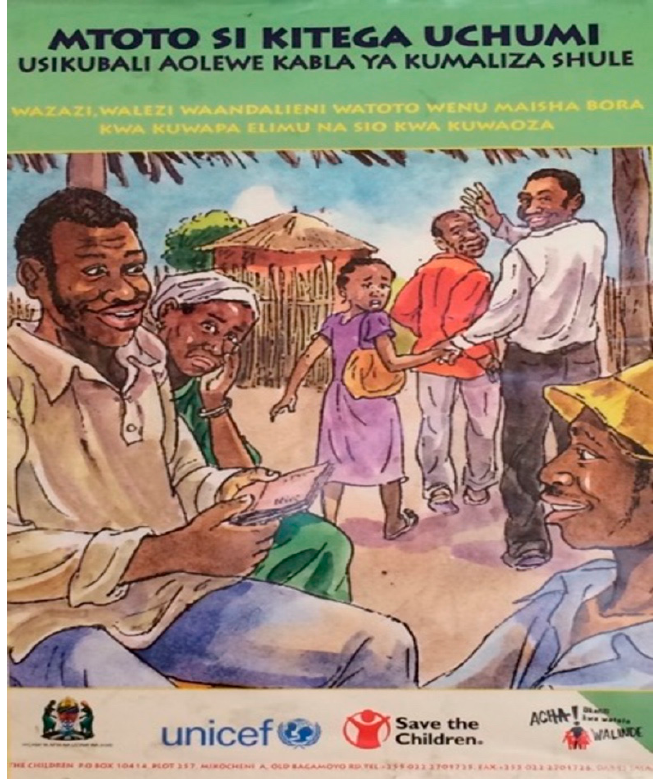
Figure 1. Photo of anti-child marriage poster displayed in a government office in Mwanza, north- west Tanzania. Swahili text reads: “A child is not a commodity. Do not let her marry before she finishes school. Parents and caregivers, give your children a better life by giving them an educa- tion and do not let them marry.” Photo by: David Lawson.